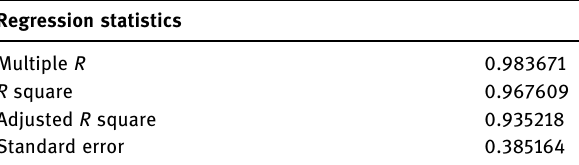
Table 1: Regression analysis of hardness and impact strength Regression statistics